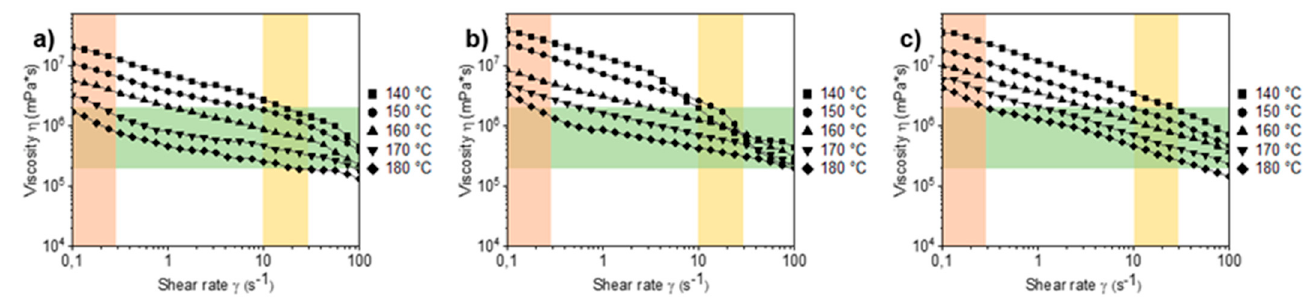
Figure 3. Rheology measurements of ( a ) SIBS-B4; ( b ) SIBS-B4 mixed with TA (1 wt %); ( c ) SIBS-B4 mixed with TA (5 wt %) displaying viscosity η vs. shear rate γ measured at different temperatures.